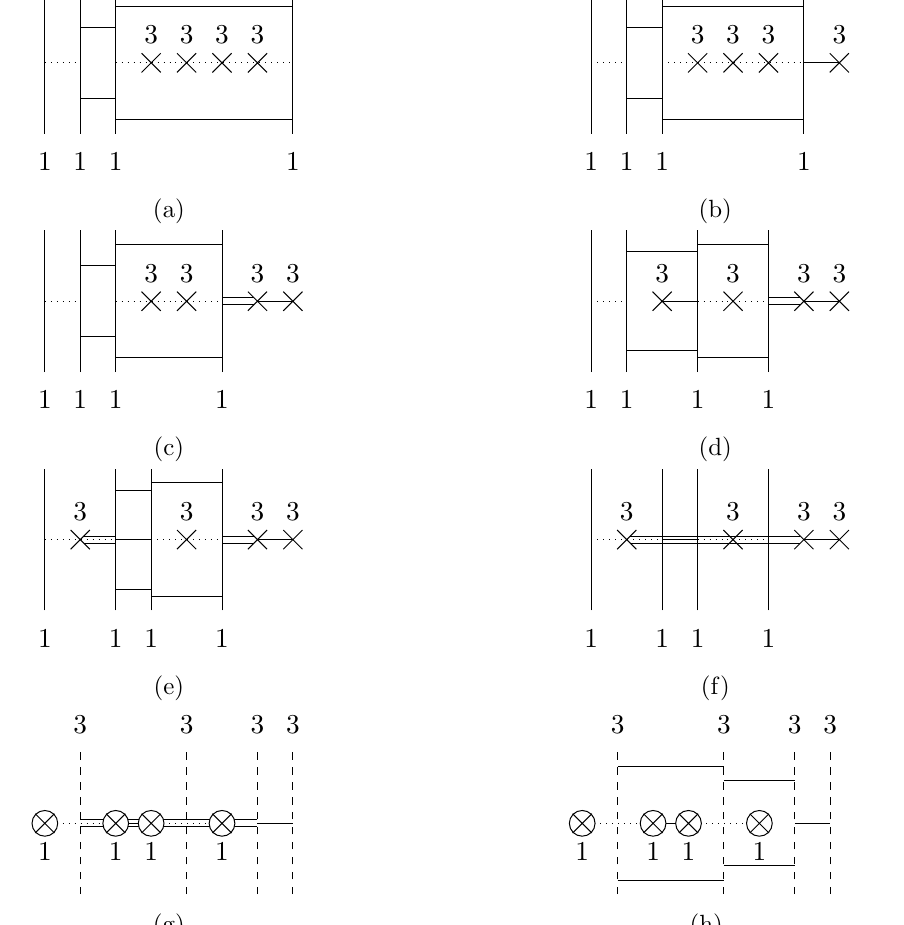
Figure 17. Higgsing of the model with ~l d = (3 ; 3 ; 3 ; 3), ~l s = (1 ; 1 ; 1 ; 1), and rightmost orientifold plane O 3 (cid:0) . (a) represents the Coulomb branch brane con(cid:12)guration. (b-g) are one step phase transitions and (h) is the Higgs branch brane con(cid:12)guration. half NS5-branes are represented with circled crosses, (cid:12)gure 17(g). In the (cid:12)nal step one can realign and split the half D3-branes into half D3-brane segments that end in D5-branes, (cid:12)gure 17(h). This is the Higgs branch brane